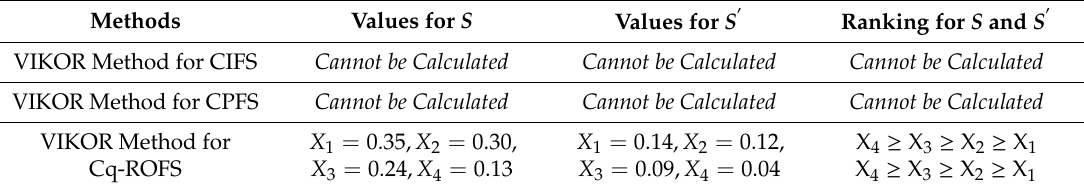
Table 6. Comparison between proposed approaches and existing approaches.